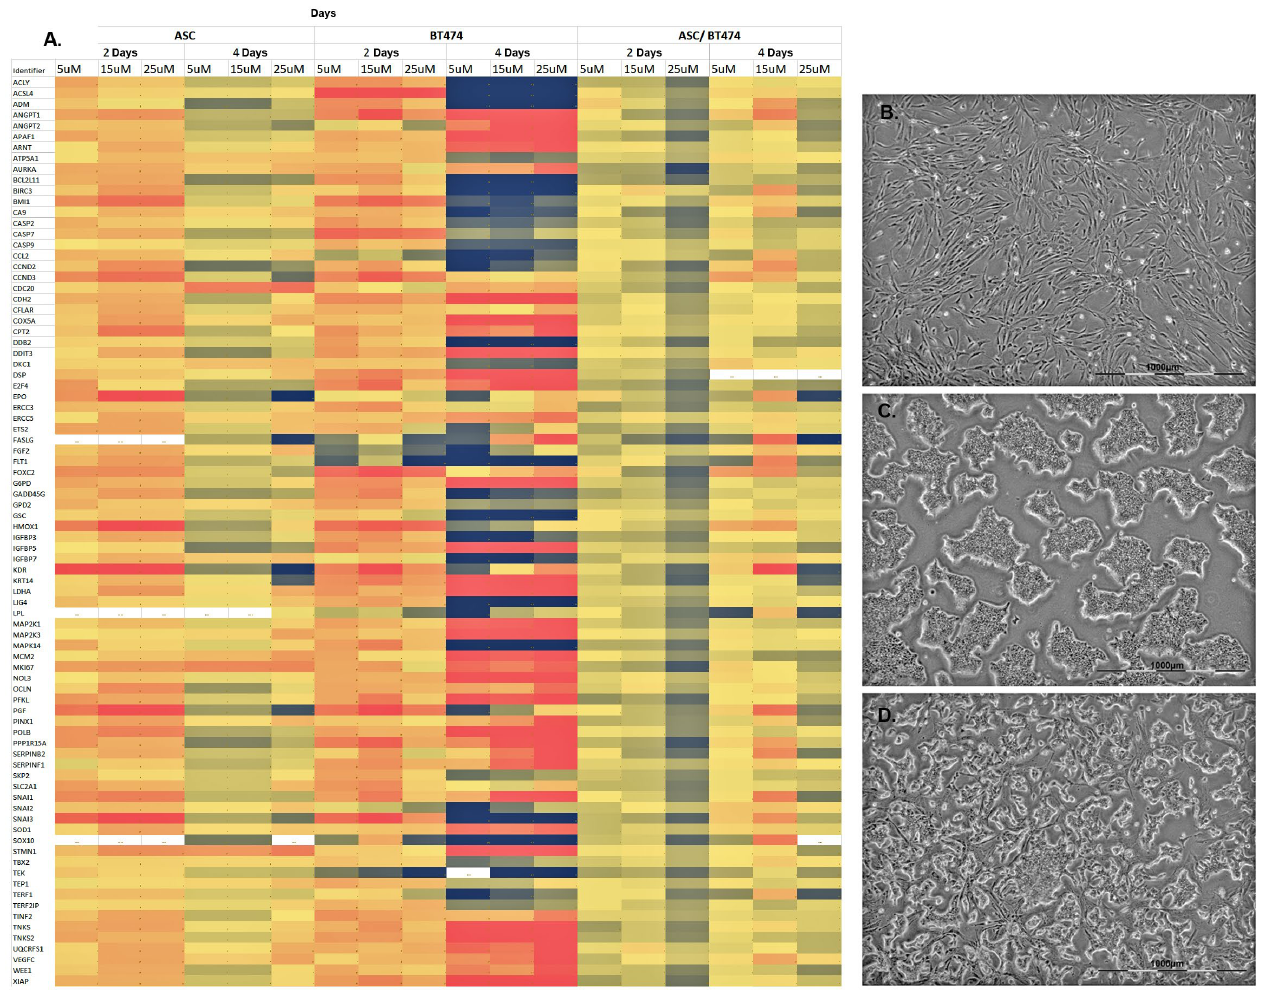
Figure 4. Gene expression of the examined genes of the PCR arrays of ASC, BT-474 cells and corresponding co-cultures. ( A ) From left to right, ASC, BT-474 cells and co-culture were each treated with 5 µ g, 15 µ g or 25 µ M tamoxifen for 48 or 96 h. The color coding (see Figure 2) indicates a relative increase (black) or reduction (red) in gene expression. The 84 genes studied and their associated pathways in tumorigenesis and transformation are listed in Table 1. ( B ) ASC of passage 2 after treatment with 25 µ M tamoxifen after 96 h in culture. ( C ) BT-474 cells of passage 15 after treatment with 25 µ M tamoxifen after 96 h in culture. ( D ) Co-culture of ASC and BT-474 cells after treatment with 25 µ M tamoxifen after 96 h in